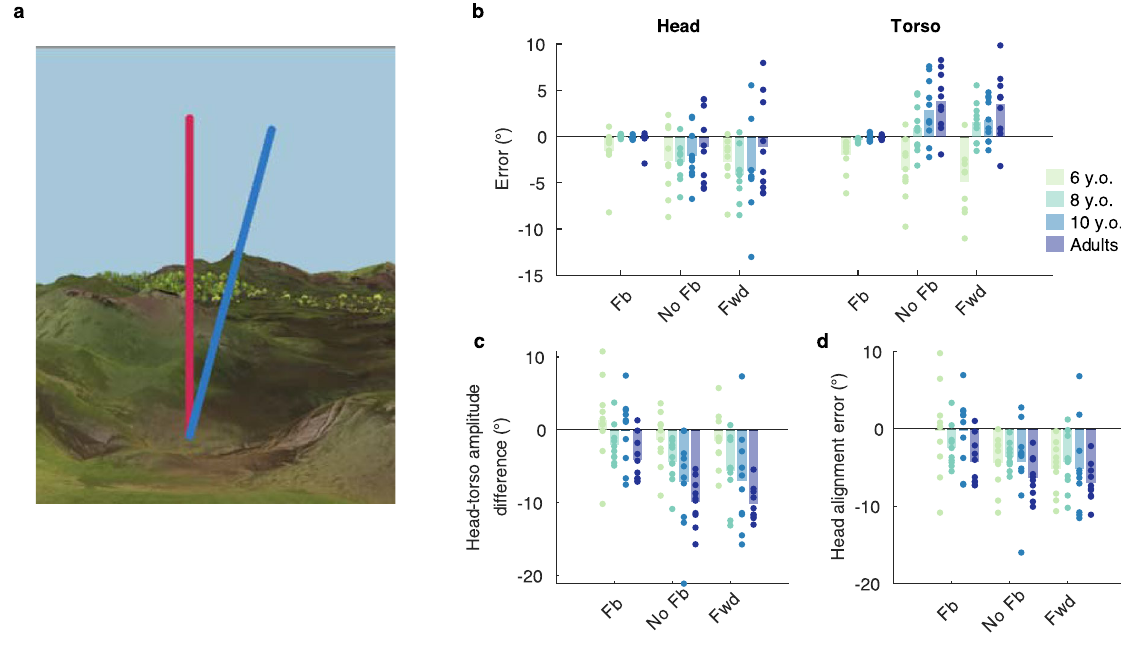
Figure 5. Joint angle reproduction (JAR) test. ( a ) Virtual setting for the Feedback condition. The blue line indicates the target orientation and the pink line the current orientation of the tested body part. ( b ) Signed error at final orientation, positive values indicate final positions exceeding the target angle. ( c ) Difference of head and torso final orientation in the torso JAR, Negative values indicate that the head angle is smaller than the torso angle. ( d ) Difference between final head orientation and target orientation in the torso JAR. Dots represent the average error for each individual participant, bars the average across participants. N = 10 for each age group. Fb: Feedback, No Fb: No feedback, Fwd: Forward, see text for description of the conditions.